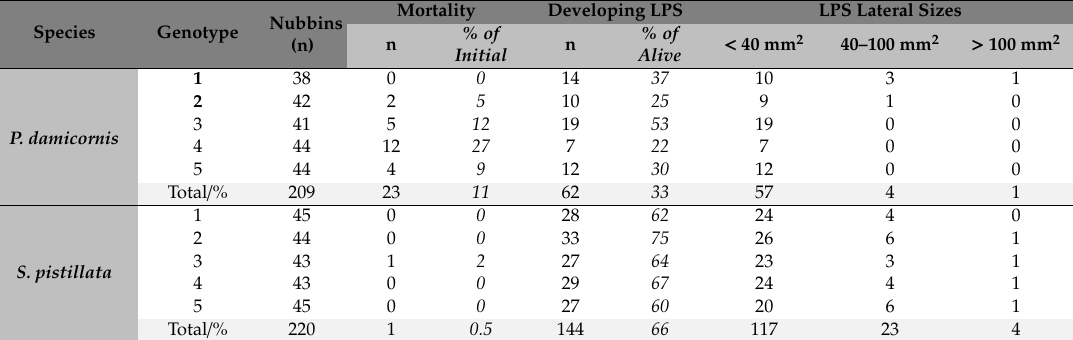
Table 1. The performance of the nubbins (survival, established LPS), sorted according to the di ff erent genotypes / coral species, on day 45. LPS-Lateral Skeleton Preparative [12]. Mortality Developing LPS LPS Lateral Sizes Species Genotype Nubbins % of (n) n Initial